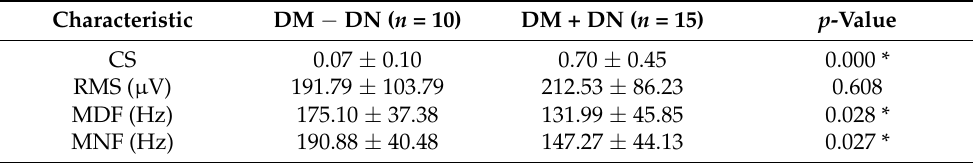
Table 3. NCS and muscle characteristics of DM patients with or without DN. (* p < 0.05).